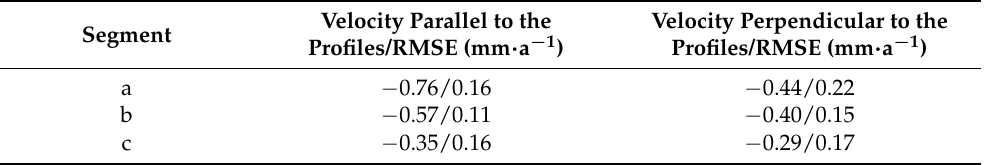
Table 3. Slip rates on the central and southern segments of the Tanlu fault zone (left-lateral with tension is